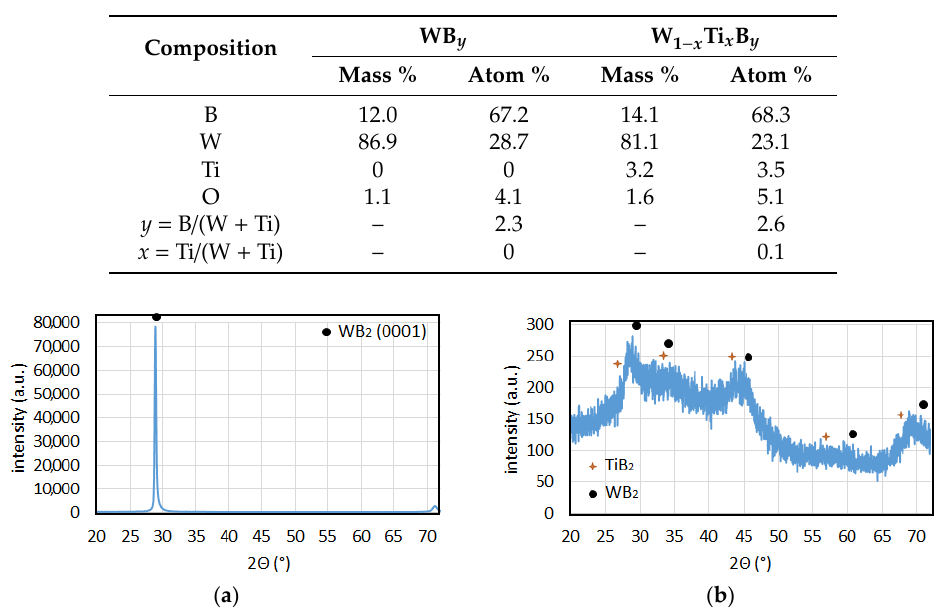
Table 1. Composition of deposited coatings.